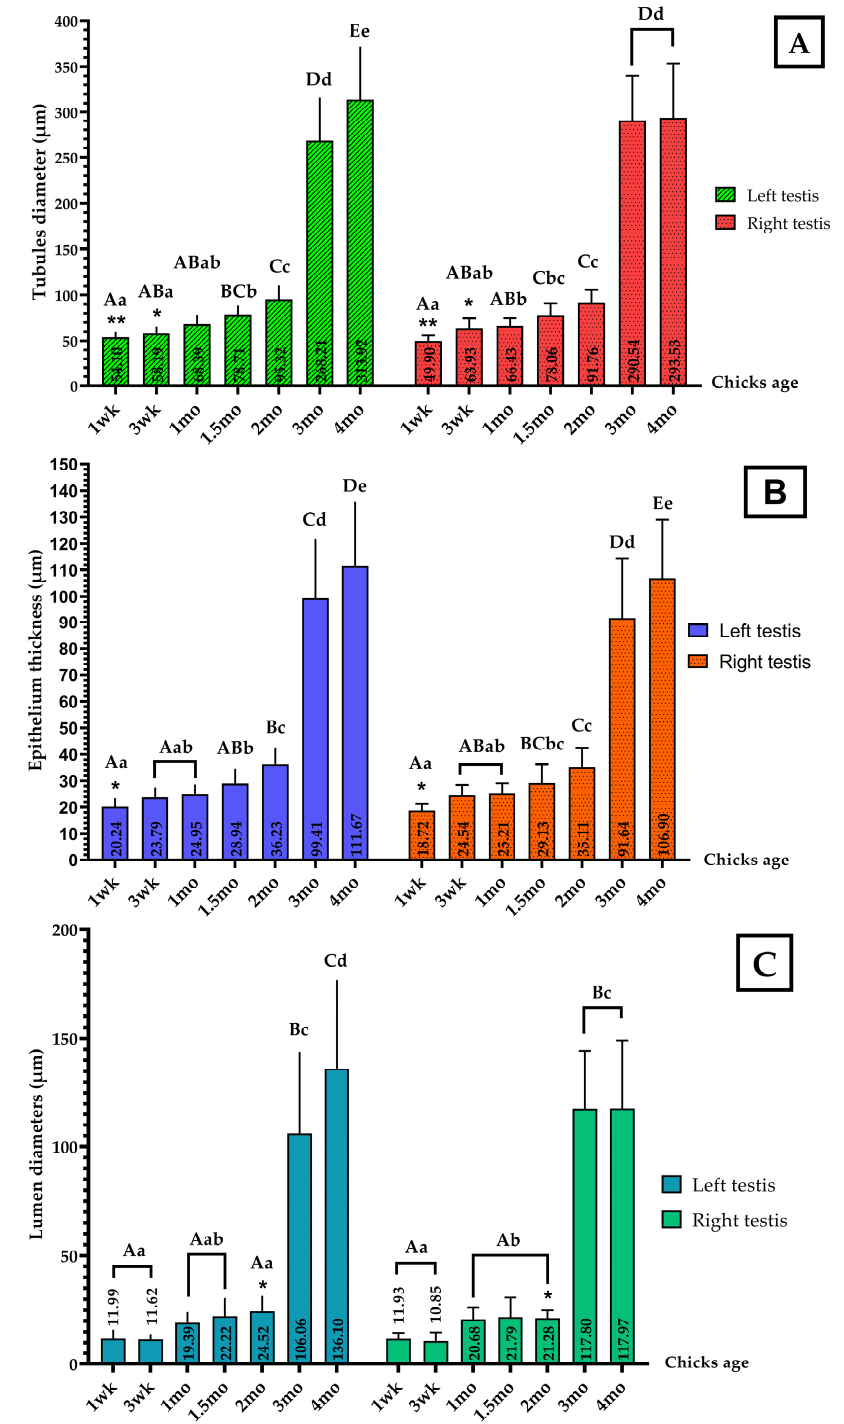
Figure 6. Seminiferous tubules’ morphometry for the growing chickens (Mean ± SD). ( A ) Tubule diameters; ( B ) tubule’s epithelium thickness; ( C ) lumen diameters. Statistical difference: ** p < 0.01; * p < 0.05; independent samples T tested for significance. Marked differences labeled by different su- perscript lowercase letters ( p < 0.05); different capital letters of superscript indicate an extremely signif- icant difference ( p < 0.01). One-way ANOVA test for significance; Duncan for multiple